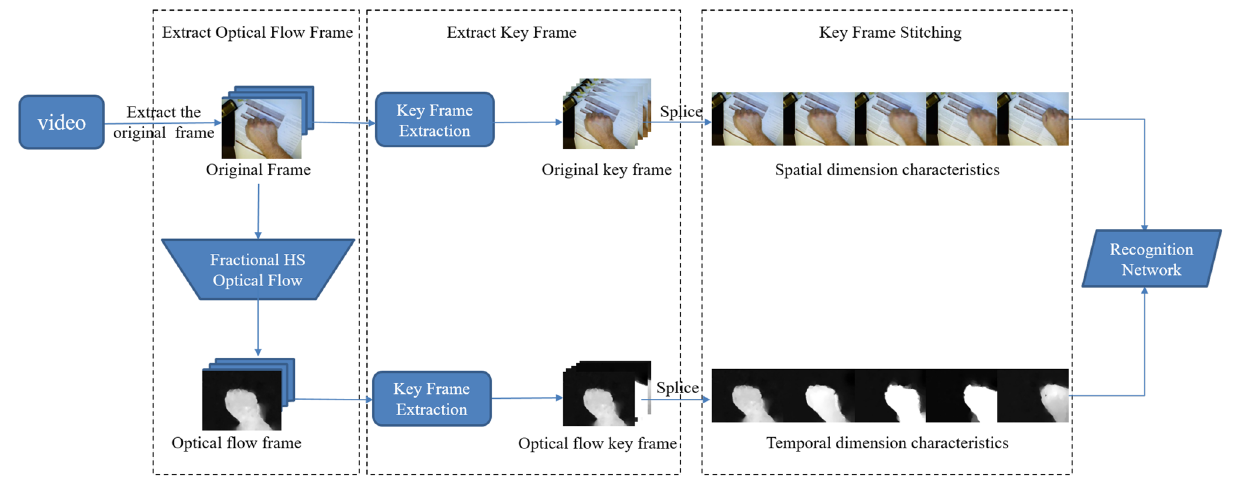
Figure 1. Overview of the proposed feature fusion